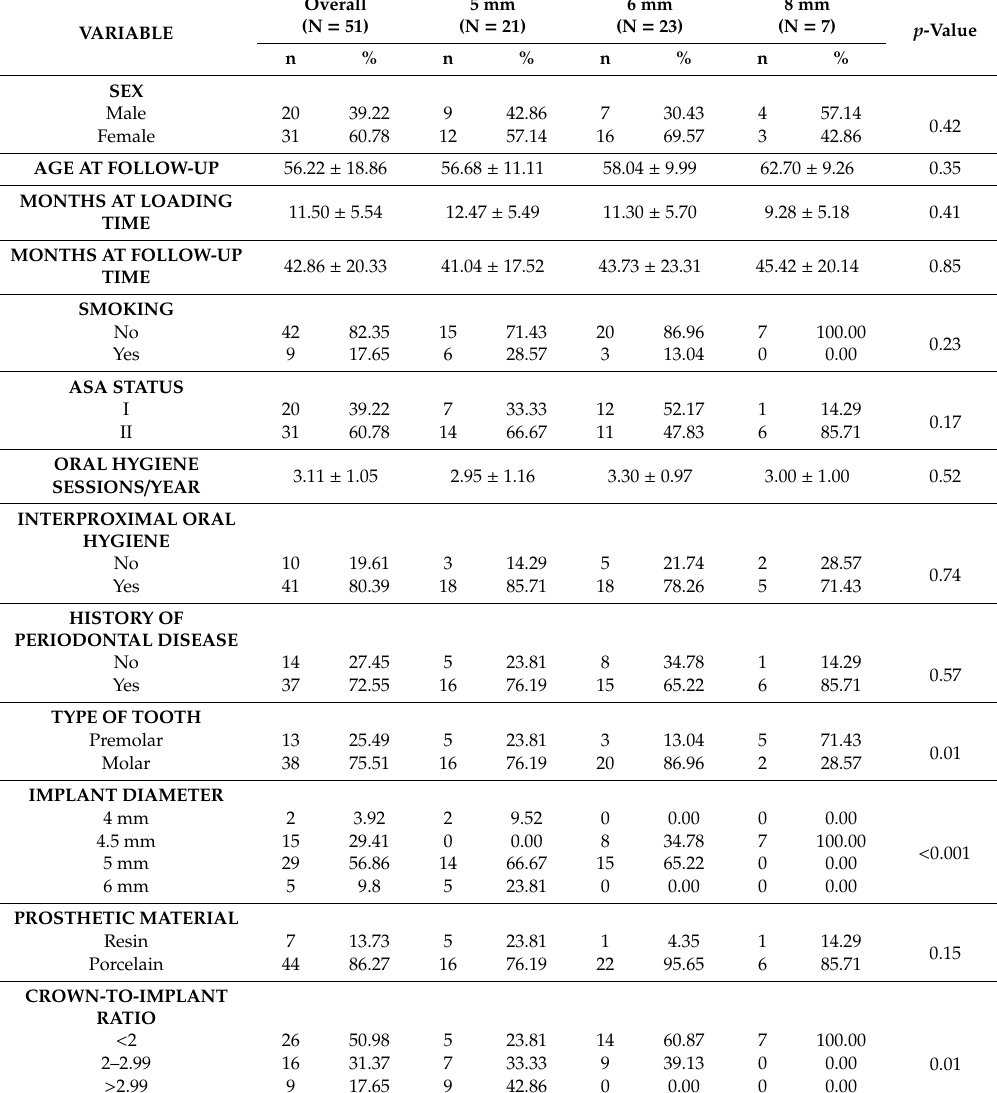
Table 1. Overall characteristics of implants placed: Length-group distribution according to study variables. Age at follow-up, months at loading / follow-up time, and oral professional hygiene / year are presented as [mean ± SD]; for all other variables, values are presented as n